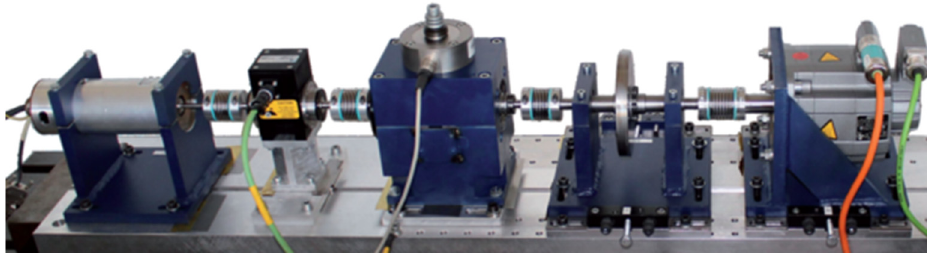
Figure 4. Paderborn university dataset experimental testbed setup.